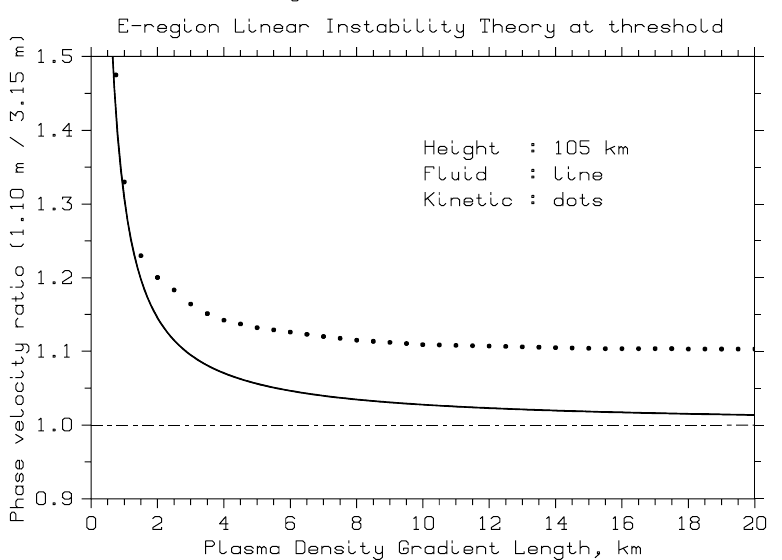
Fig. 1. Fluid and kinetic theory predictions of the phase velocity ratio at threshold of 1.10m to 3.15m FB-GD plasma waves, or 144- to 50- MHz backscatter velocity ratio of type 1 irregularities. The computations were for mid-latitude sporadic E plasma at the optimal instability altitude of 105km. As seen, kinetic effects are quite significant. Also, the gradient-drift term prevails for plasma density gradient lengths less than a few